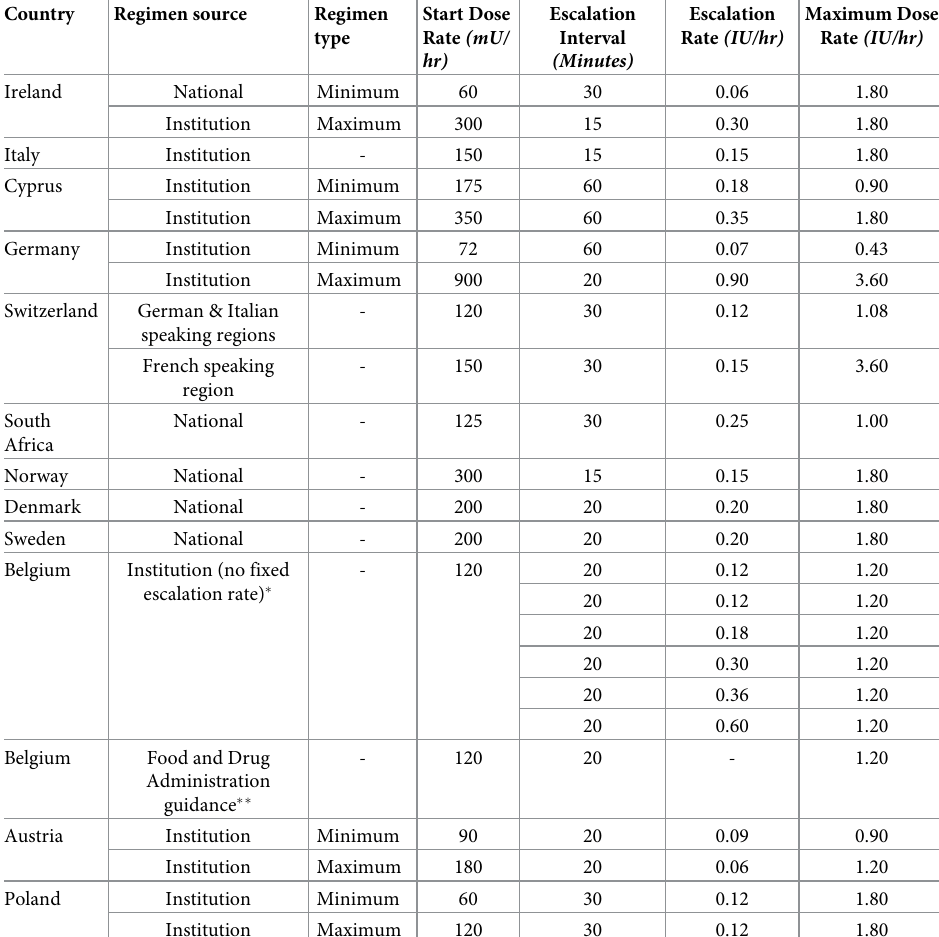
Table 3. Oxytocin infusion start dose, escalation interval, escalation rate and maximum dose